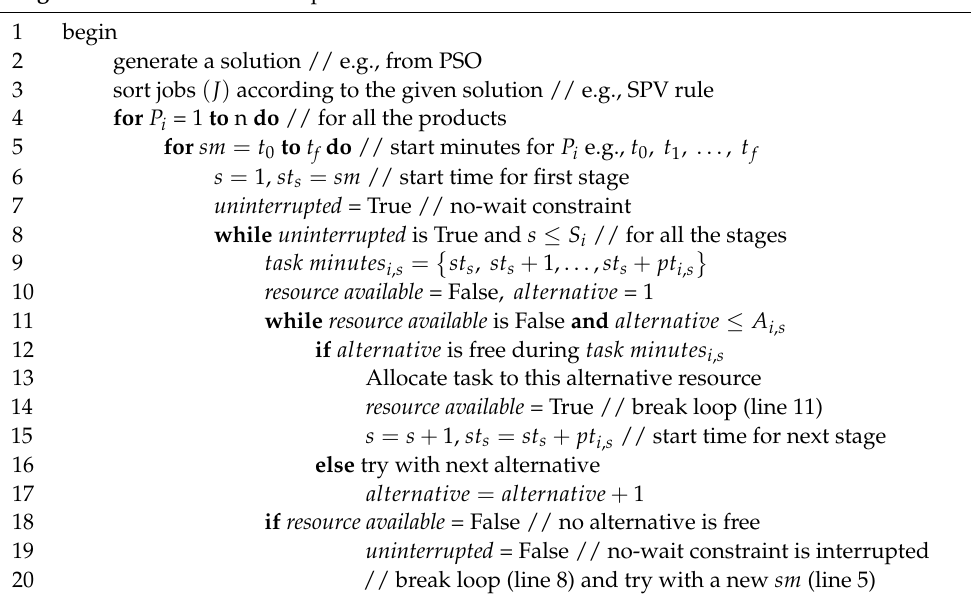
Algorithm 1. Tasks allocation procedure.